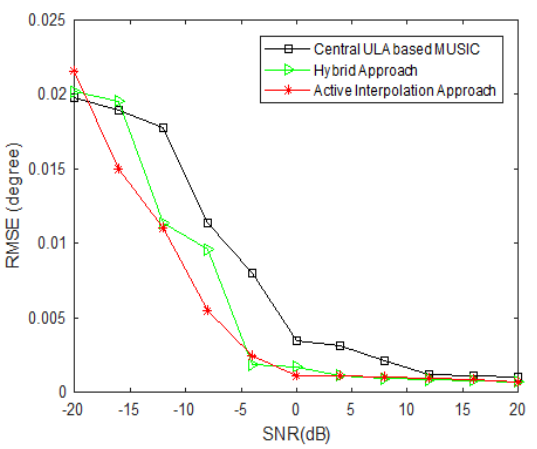
Figure 4. RMSE versus SNR (Snapshots = 100, K = 16 sources, I = 300 Monte Carlo Experiments).